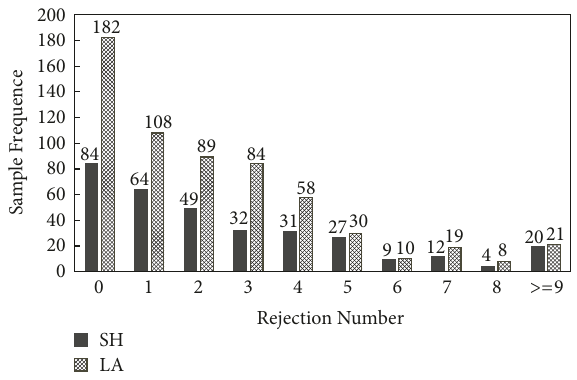
Figure 5: The distribution of the rejection number. Table 3: Percentage of merging event that at least one rejected gap largerthanacceptedgapforsampleswithdifferentrejectionnumber. Rejection